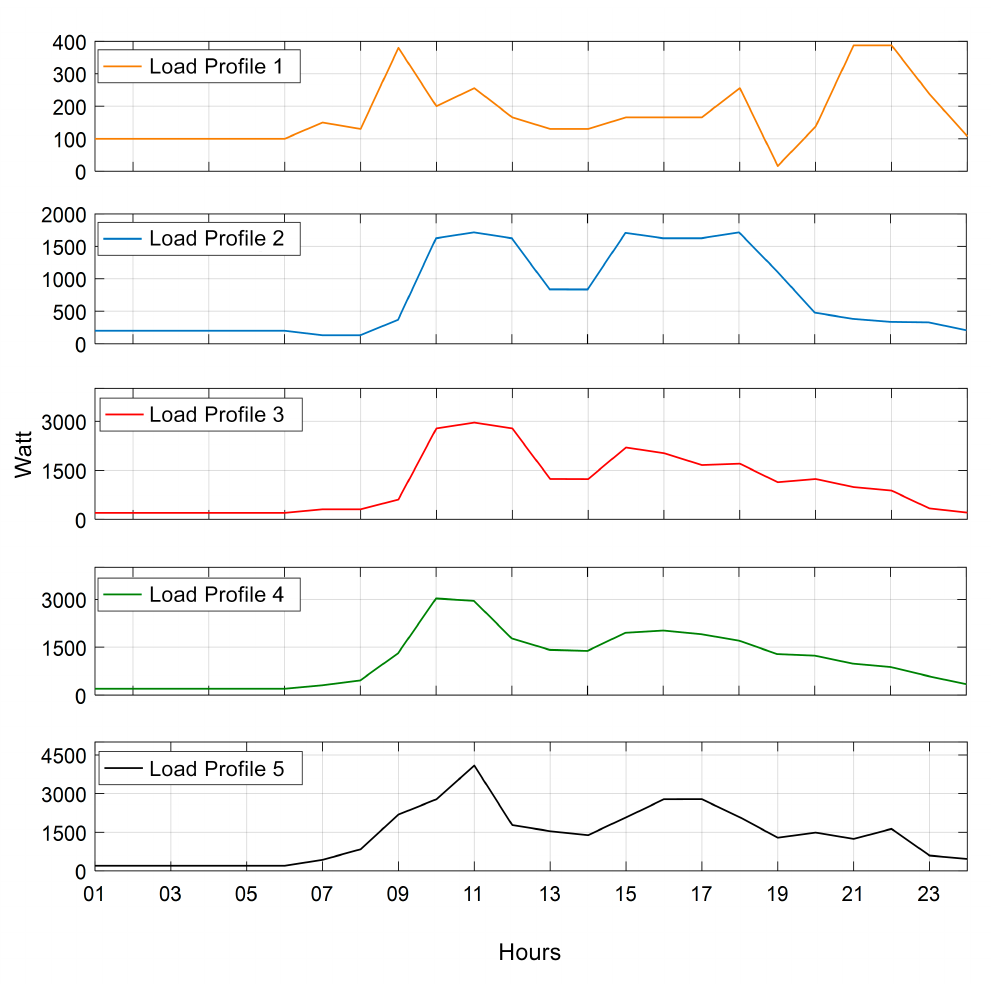
Figure 3. Load profiles in different days of the